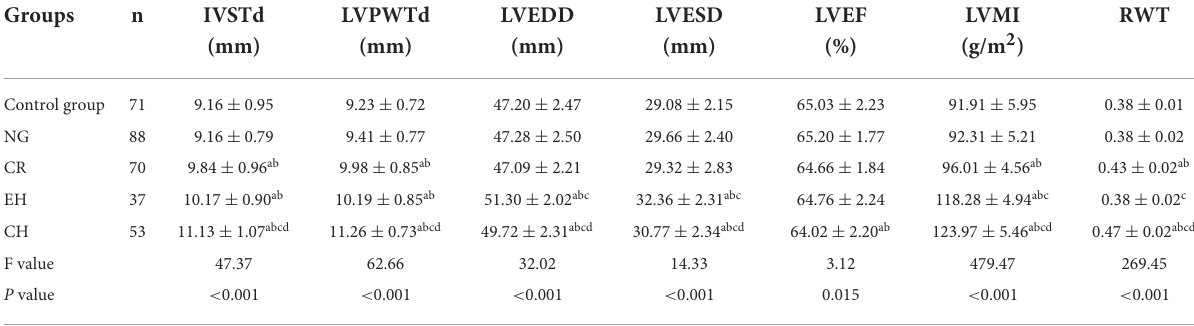
TABLE 2 Comparison among groups in terms of left ventricular echocardiographic parameters ( x ± s). Groups